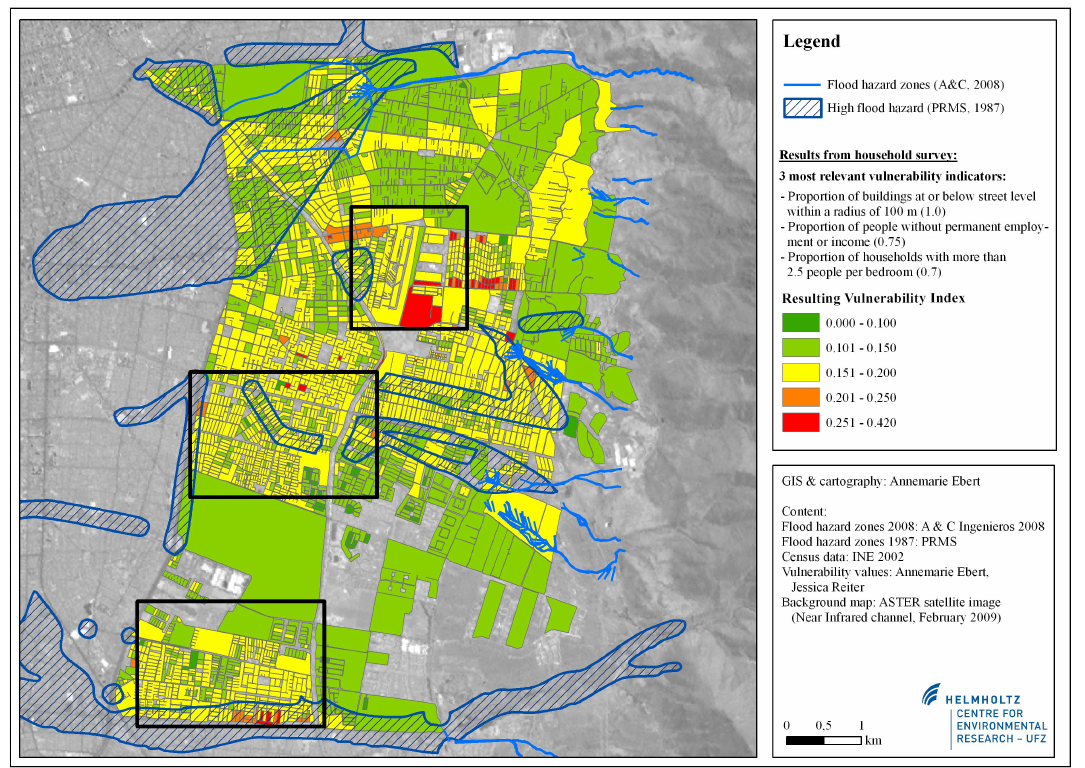
Fig. 3. Vulnerability map of the study area according to the indicator weight evaluations of the affected